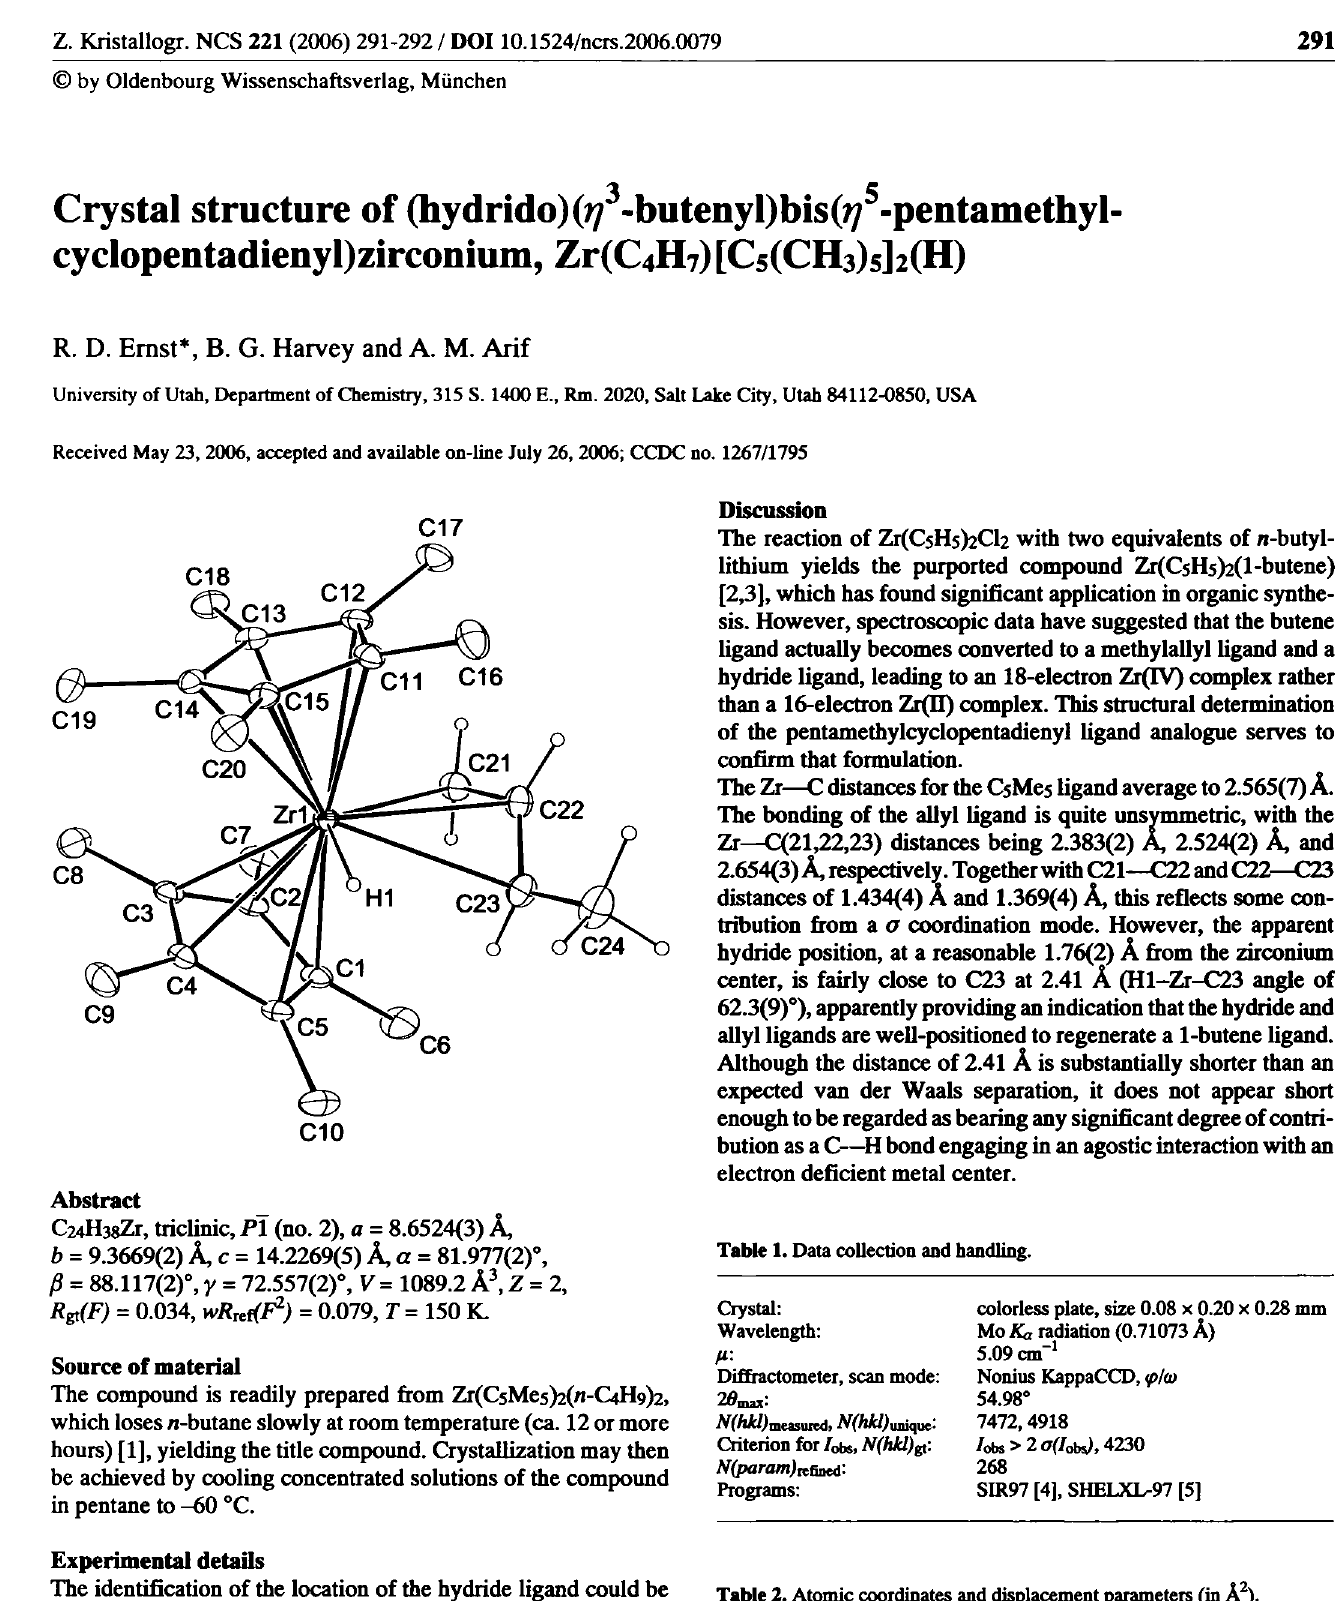
Table 2. Atomic coordinates and displacement parameters (in Ä 2